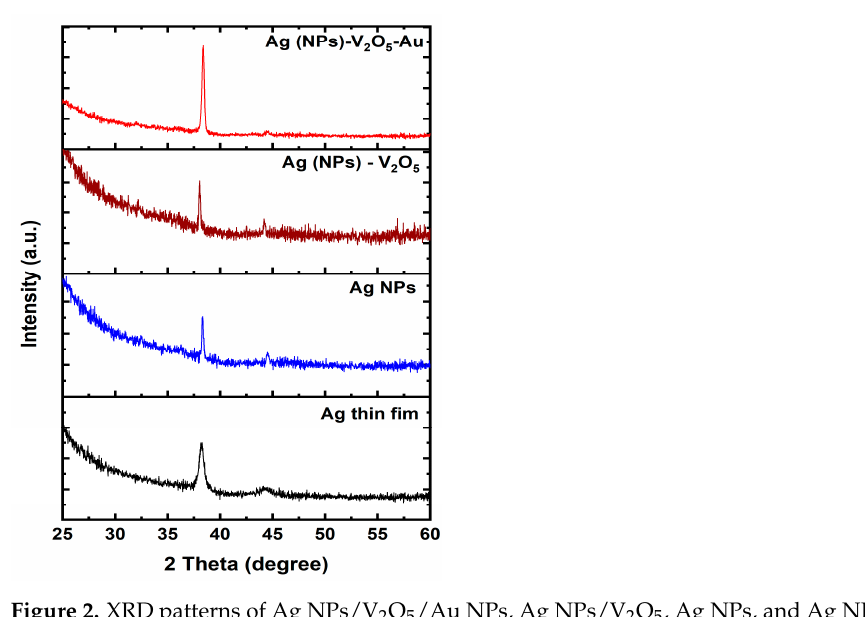
Figure 3. Raman of as-deposited Ag thin fi lm, Ag NPs, Ag NPs/V 2 O 5 thin fi lm, and Ag NPs/V 2 O 5 thin fi lm/Au NPs.